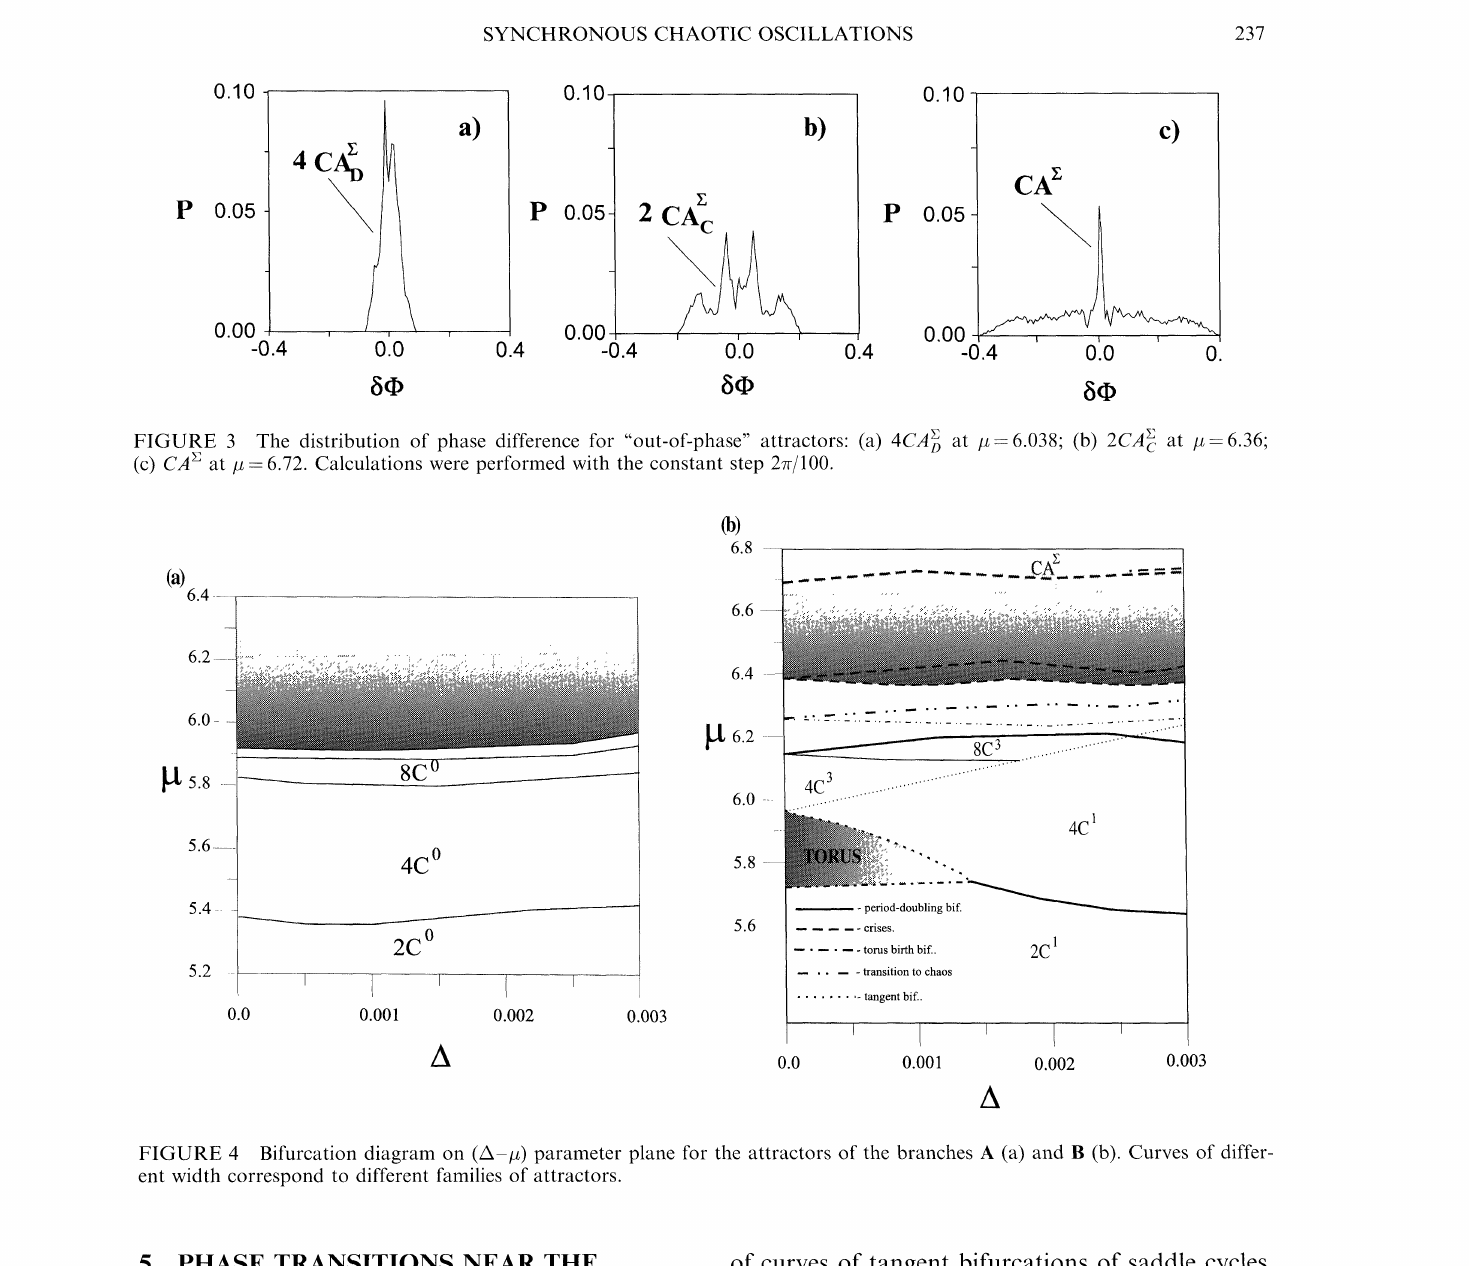
FIGURE 4 Bifurcation diagram on (A-/z) parameter plane for the attractors of the branches A (a) and B (b). Curves of differ- ent width correspond to different families of